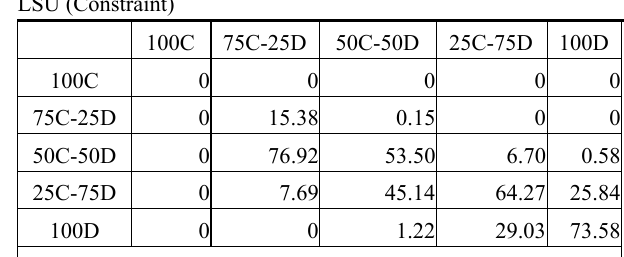
Overall classification accuracy: 60.64% Overall classification accuracy: 69.83%